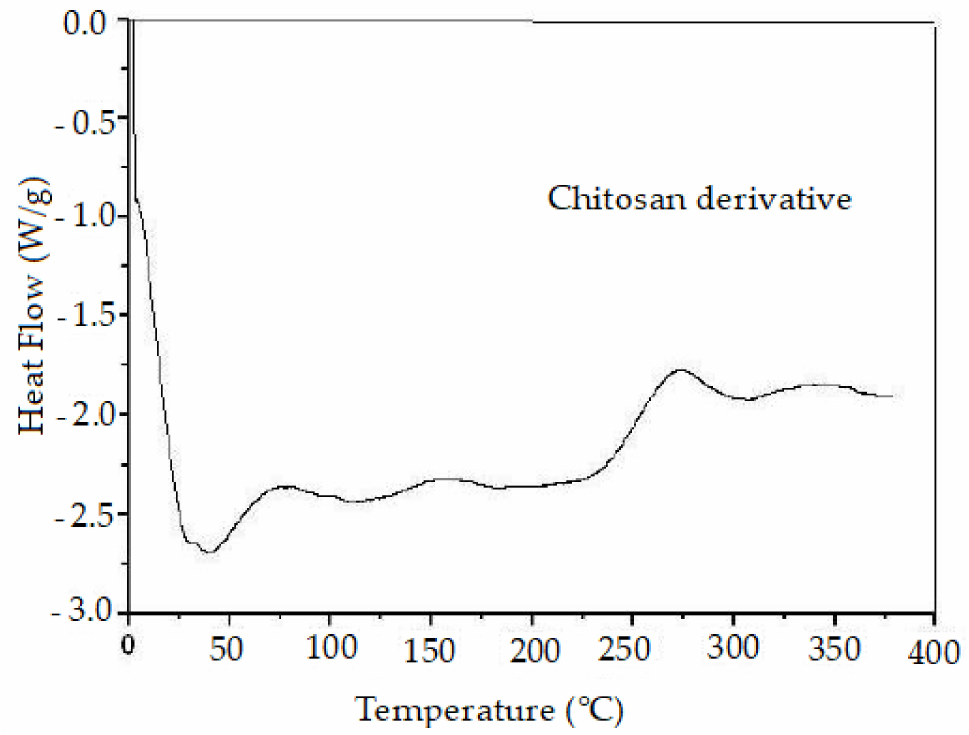
Figure 7. Differential scanning calorimetry of chitosan